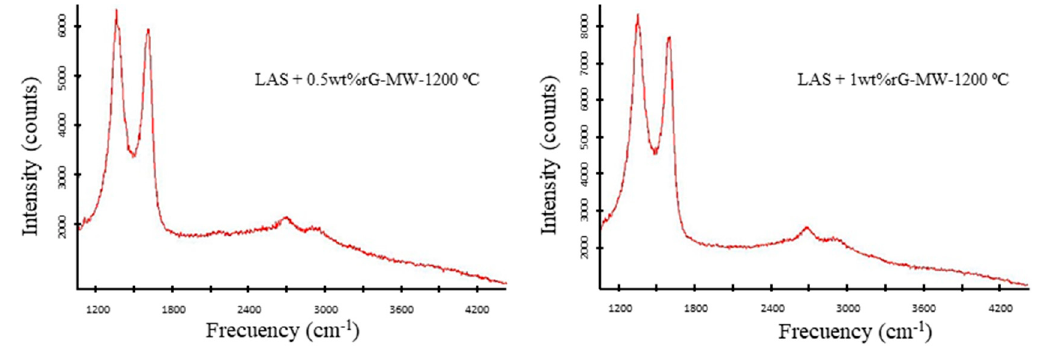
Figure 2. Raman spectrum of the LAS + 0.5 wt % rG and LAS + 1 wt % rG composites after sintering by microwave at 1200 °C.